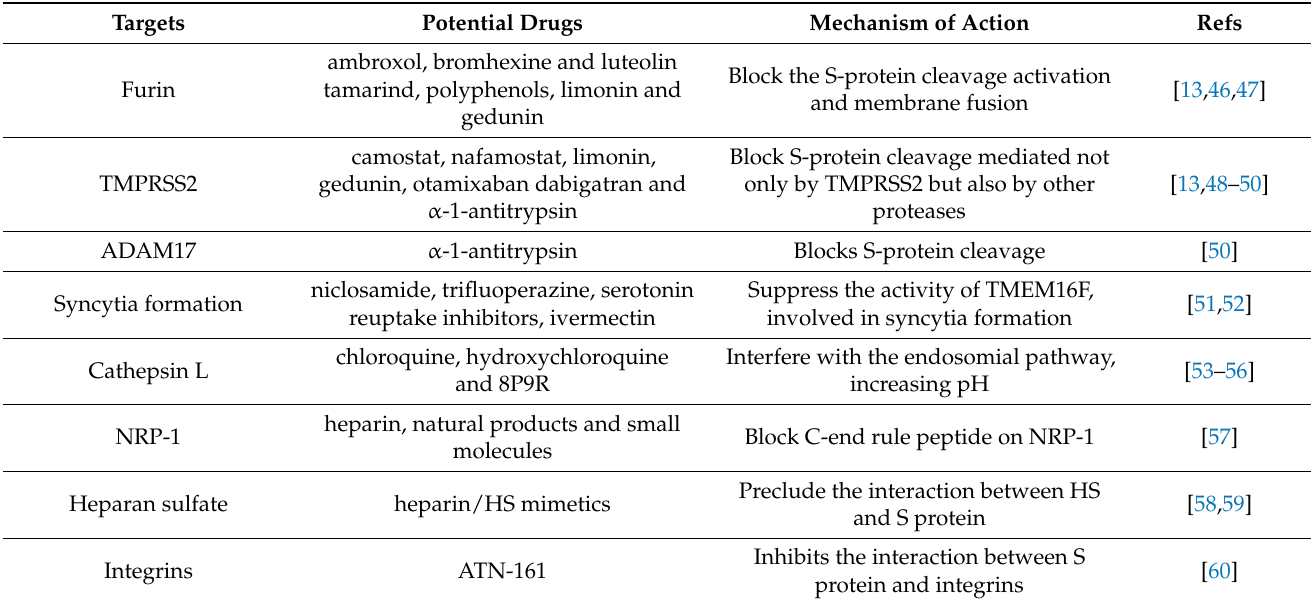
Table 2. Targets and mechanism of action of repurposed anti-SARS-CoV-2